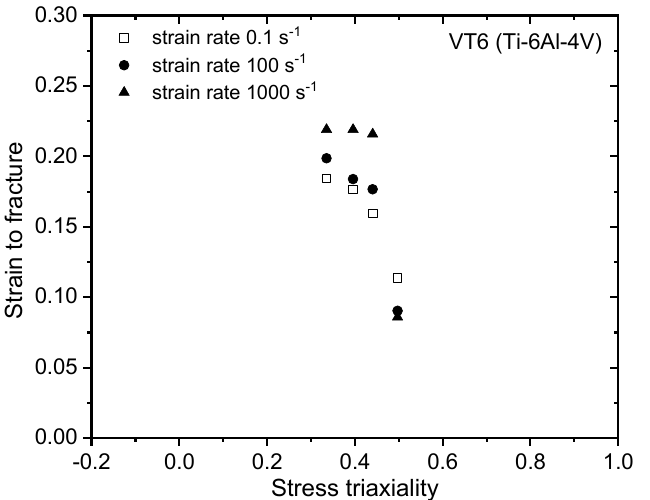
Figure 6. Strain to fracture of Ti-6Al-4V versus stress triaxiality at tension strain rates of 0.1, 10 2 , and 10 3 s − 1 .